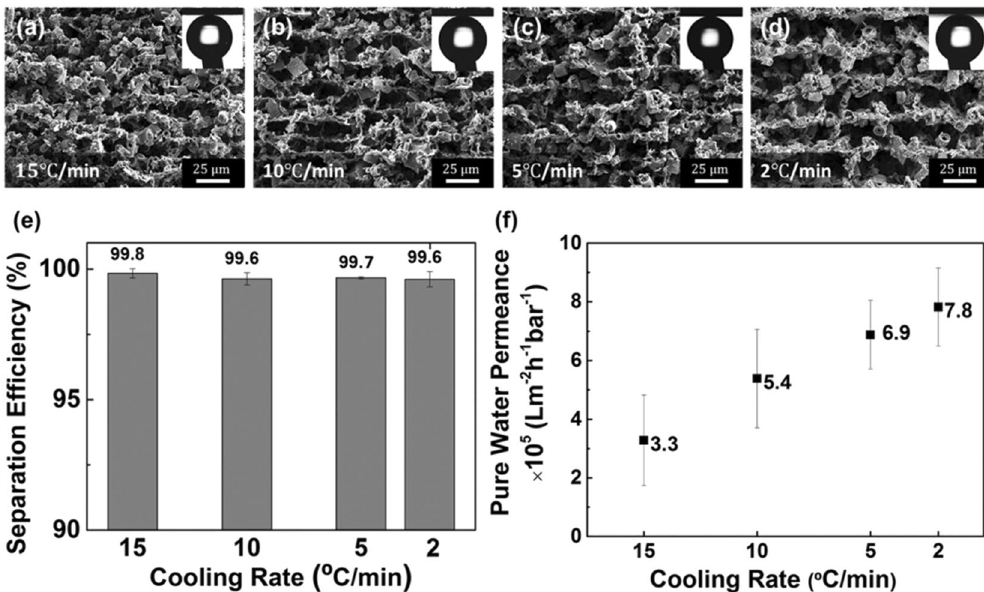
Figure 7. ( a – d ) Influence of the cooling rates on the microstructures of diatomite membranes. ( e ) Separation efficiency and ( f ) pure water permeance tested by plates synthesized with different